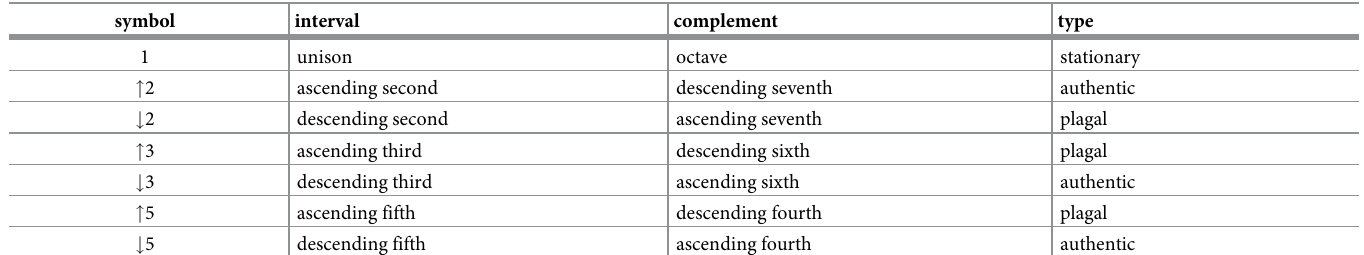
Table 1. Root progression intervals.